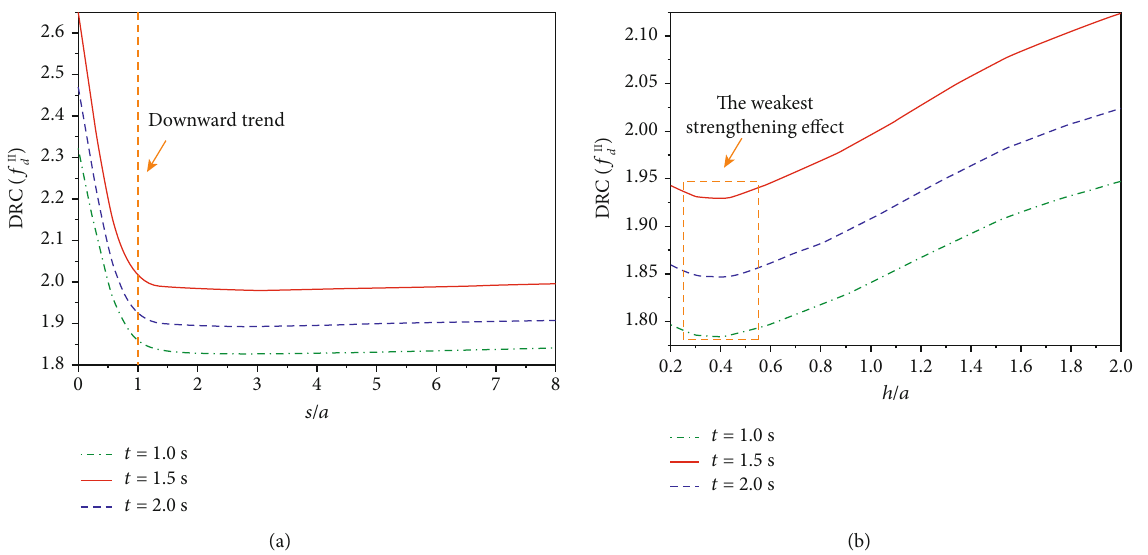
ΙΙ variations with s / a and h / a at di ff erent times. (a) h = 0 . (b) s = a . Figure 10: f d